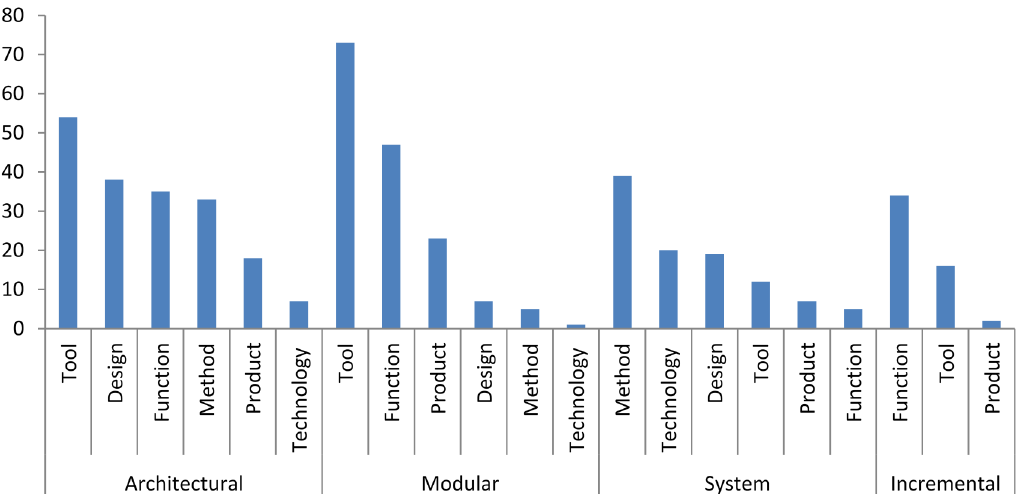
Figure 11. Spread of innovation types for each level of